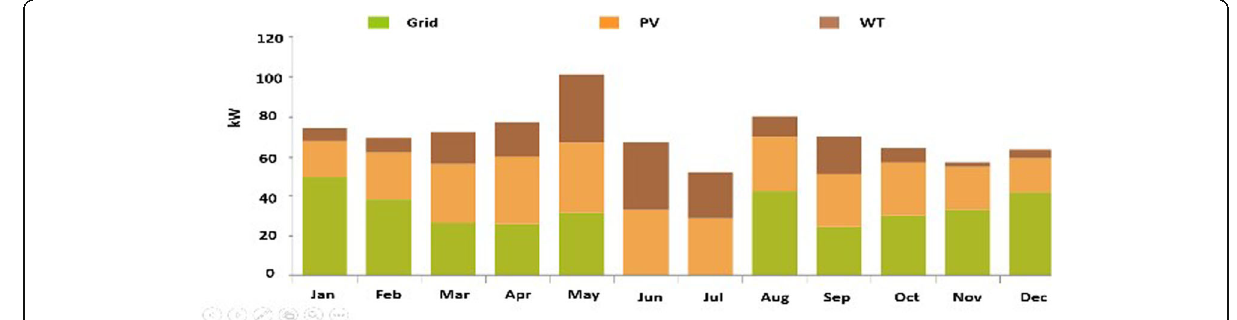
Fig. 10 Monthly average electricity production (Case